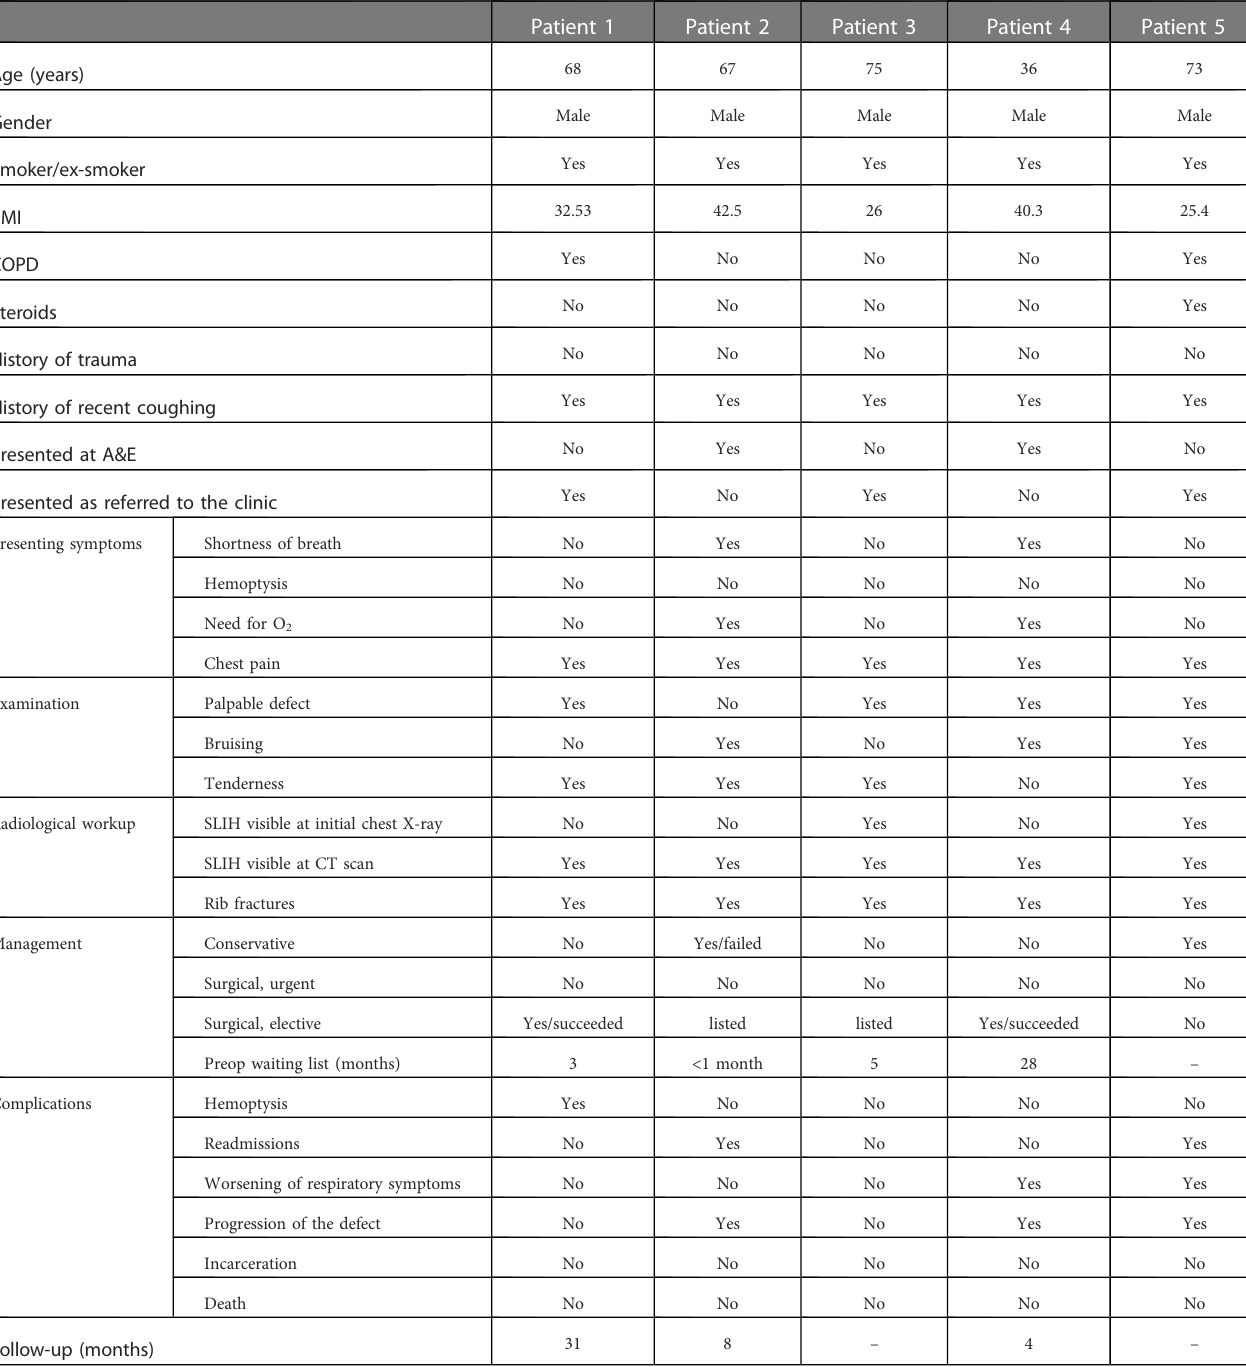
TABLE 1 Summary of the clinicoradiological features and outcomes of fi ve patients diagnosed with